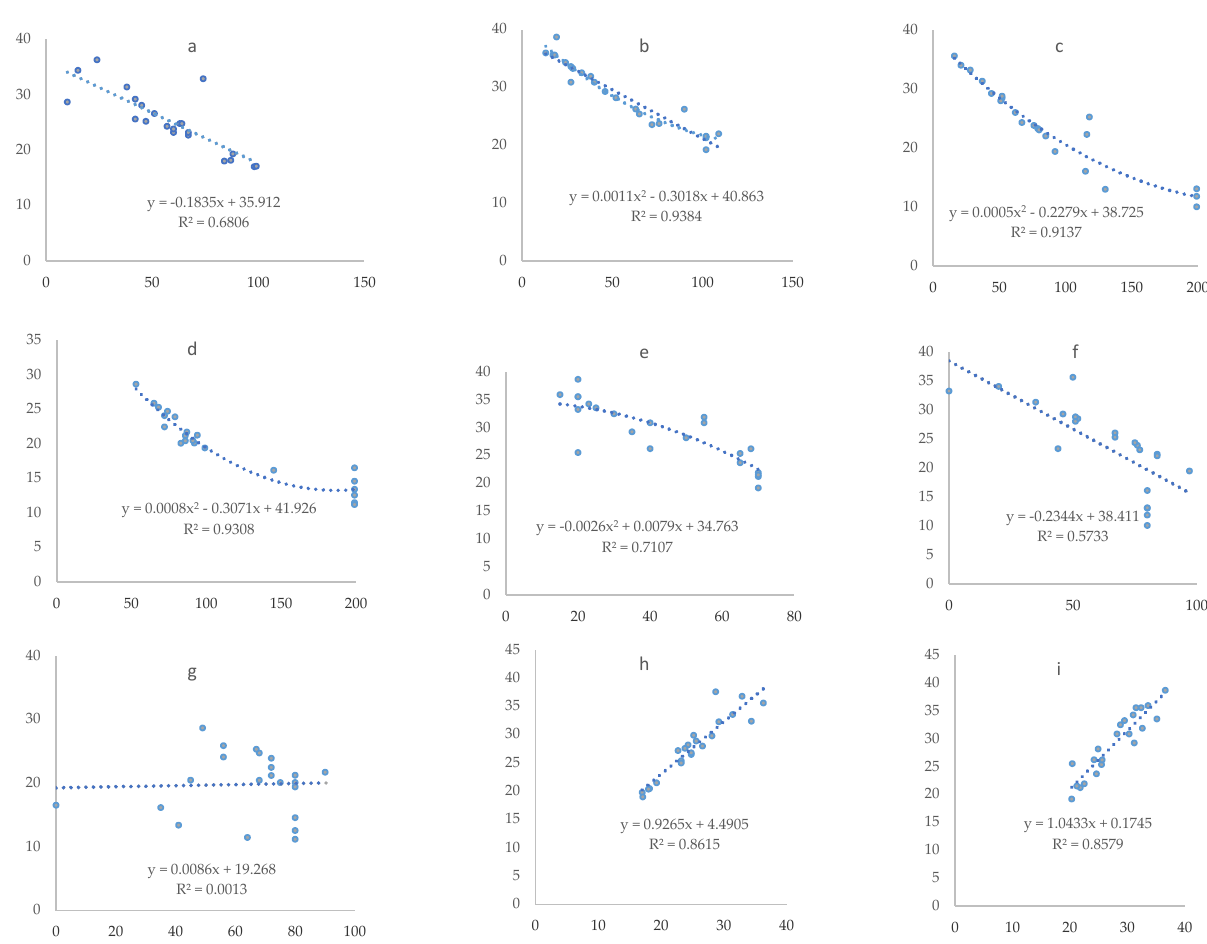
Figure 6. ( a ) Watermark vs. Soil Water Content (SWC) 10 cm, ( b ) Watermark vs. SWC 20 cm, ( c ) Watermark vs. SWC 30 cm, ( d ) Watermark vs. SWC 45 cm, ( e ) Tensiometer vs. VWC 20 cm, ( f ) Tensiometer vs. VWC 30 cm, ( g ) Tensiometer vs. VWC 45 cm, ( h ) Time Domain Reflectometry (TDR) vs. VWC 10 cm, ( i ) TDR vs. SWC 20 cm.